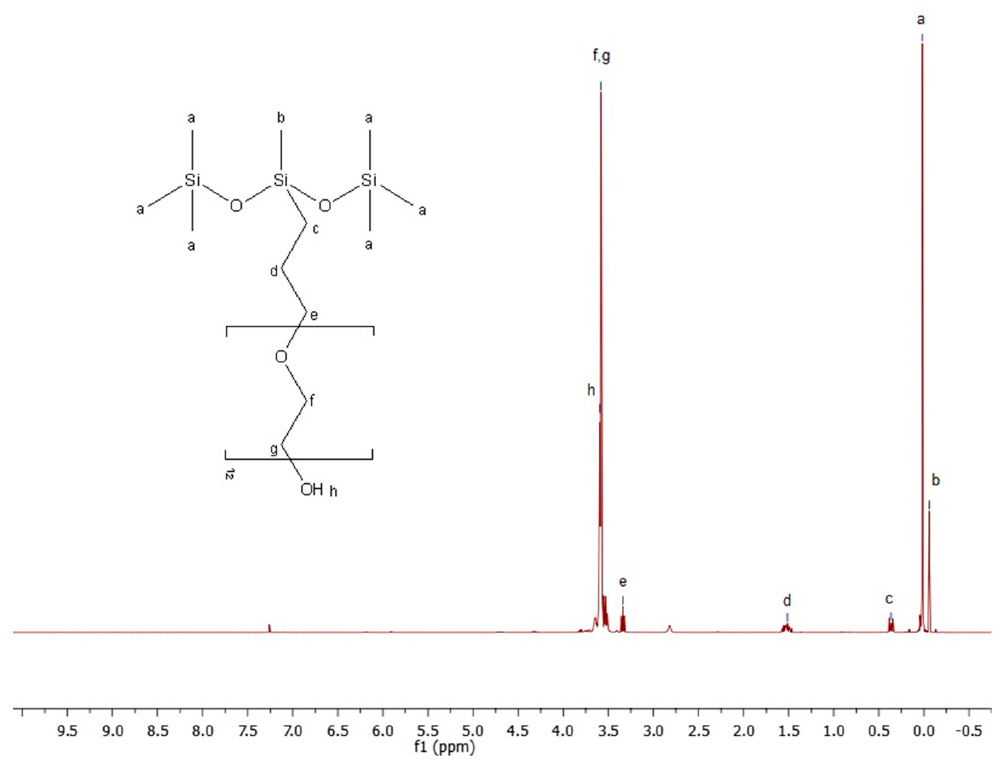
Figure 4. 1 H-NMR spectrum of the product.